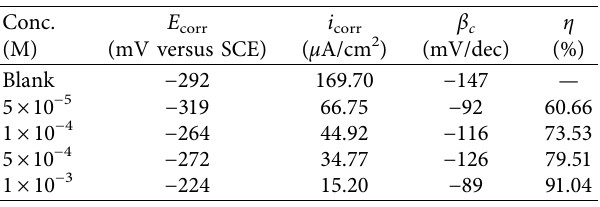
Figure 2: Potentiodynamic polarization for SS in 1M H containing different concentrations of ACM at 293K. Table 2: Tafel polarization parameters and corresponding inhi- bition efficiency for SS in 1M H 2 SO 4 containing different con- centrations of ACM at